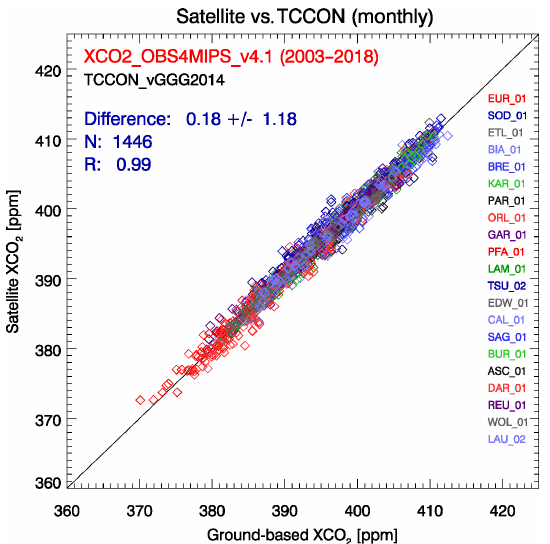
Figure 13. Summary of the comparison of product XCO2_OBS4MIPS with TCCON monthly mean XCO 2 (each symbol corresponds to one month and to one TCCON site; each color corresponds to a different TCCON site; TCCON site colors and site IDs (see Table 3) are shown on the right). The comparison is based on 1446 monthly values. The mean difference (satellite – TCCON) is 0.18ppm and the standard deviation of the difference is 1.18ppm. The linear correlation coefficient R is 0.99.